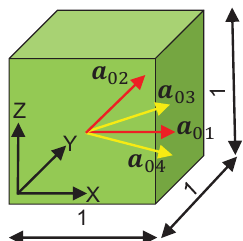
Figure 3. A linear brick FE showing fiber directions with dimension units in